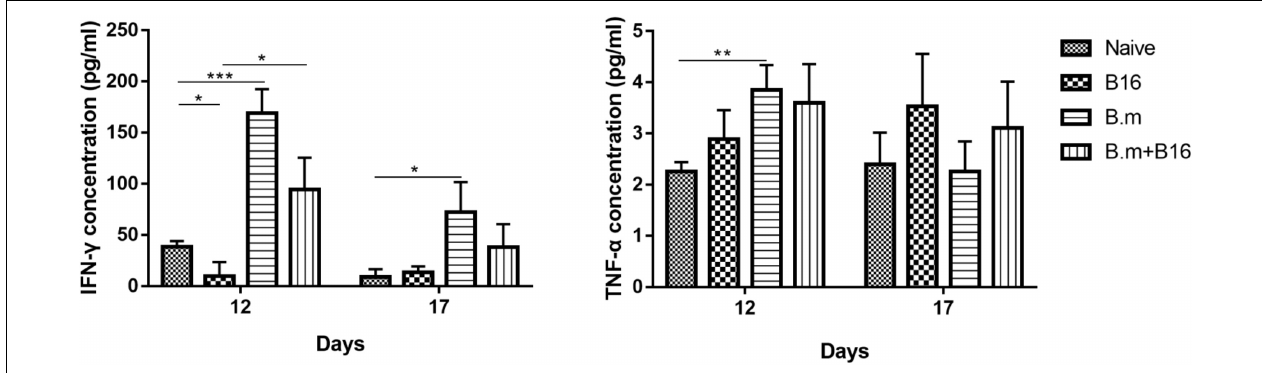
FIGURE 3 | Effects of B. microti infection on the concentration of IFN- γ and TNF- α in mouse serum on days 12 and 17 post-tumor cell injection. Mice serums of the four groups were collected on days 12 and 17 post-tumor cell injection, respectively, and the concentration of IFN- γ and TNF- α in serum was detected by using the ELISA kit. Error bars are SD; * p ≤ 0.0332,** p ≤ 0.0021, *** p ≤ 0.0002. There were five mice in each